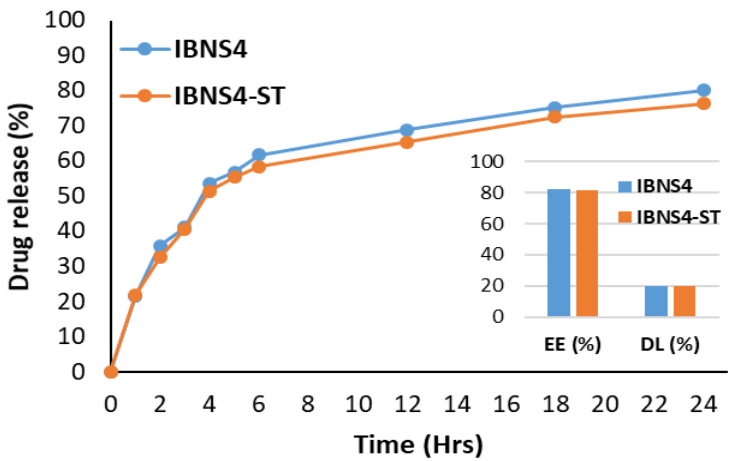
Figure 9. Cumulative release profile after